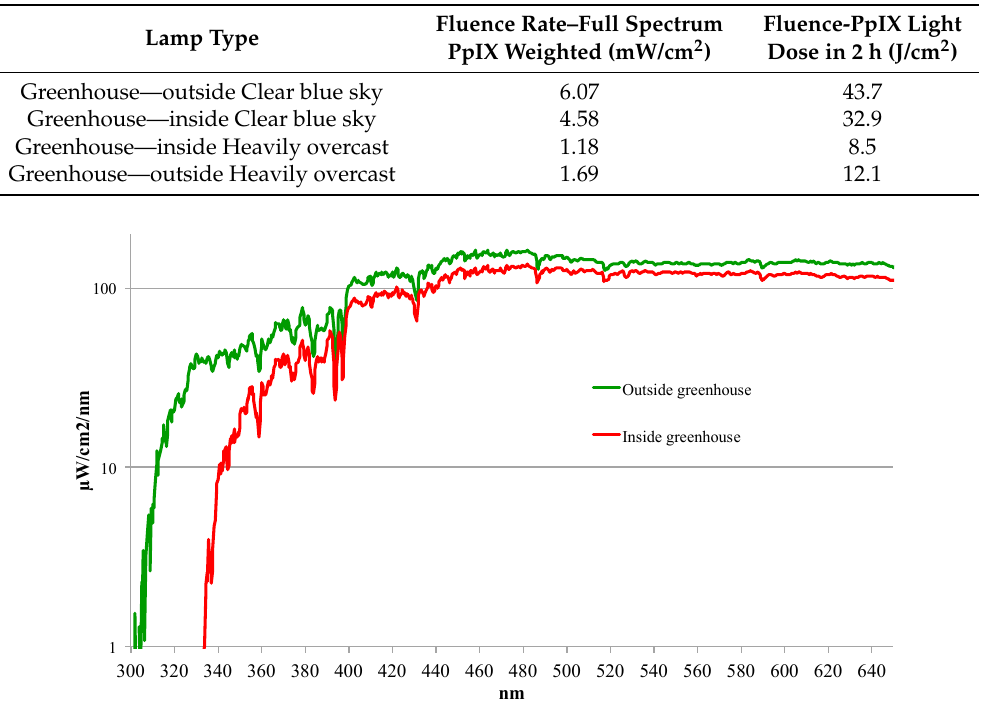
Table 3. PpIX-weighted full spectrum and PpIX light doses in two hours of daylight outside and inside the greenhouse during different weather conditions.